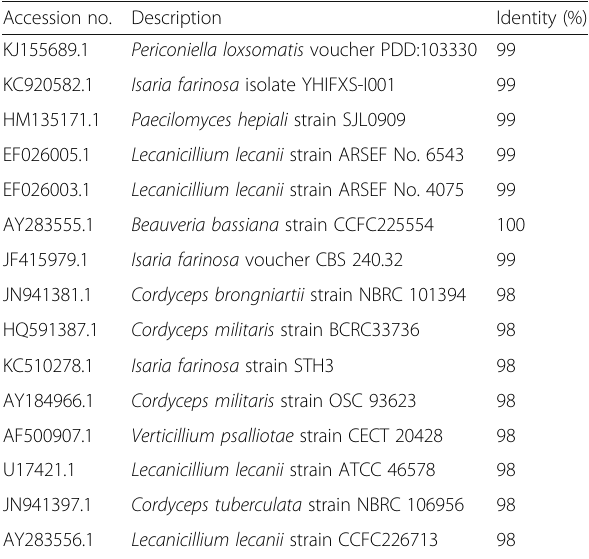
Table 1 The list of fungal strains along with their respective GenBank accession number, and their identity score, that produce significant alignments with the query consensus sequence (CS) achieved from isolated Beauveria